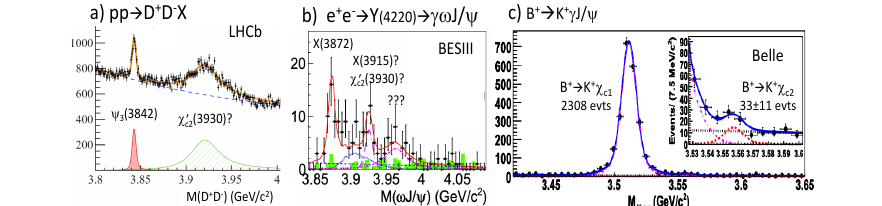
Figure 5. a) The M ( D + D − ) distribution for inclusive D -meson pair production at the LHCb. The peak at 3842 MeV is the first observation of the ψ 3 , the 1 3 D 3 charmonium level. The broader peak near 3920 MeV is attributed by the LHCb group to the χ (cid:48) [18]. b) The M ( ω J /ψ ) distribution for e + e − → Y (4220) → ω J /ψ events from BESIII. c 2 An X (3872) → ω J /ψ signal is evident. Additional peaks near 3925 MeV and 3960 MeV each have about 3